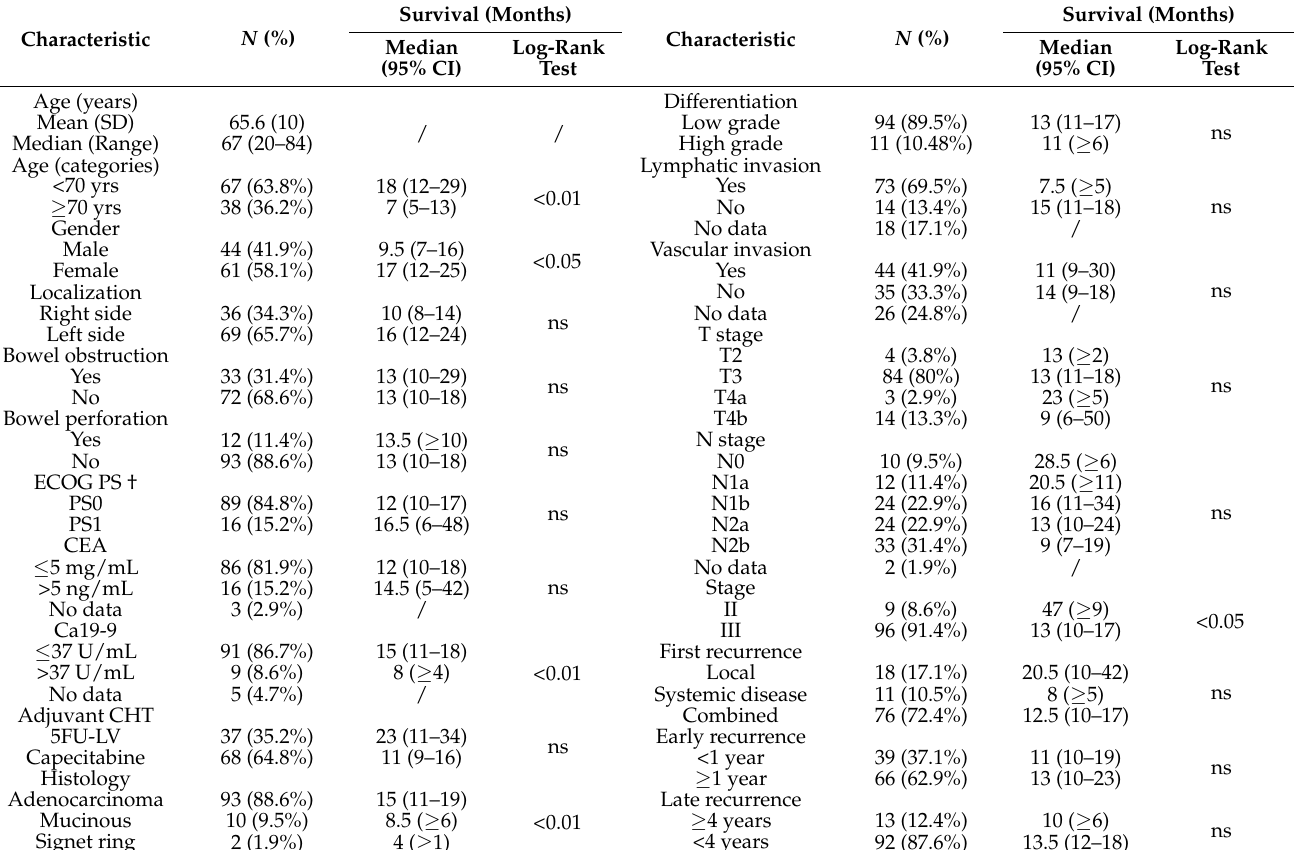
Table 2. Patient and disease characteristics and influence on post-recurrence